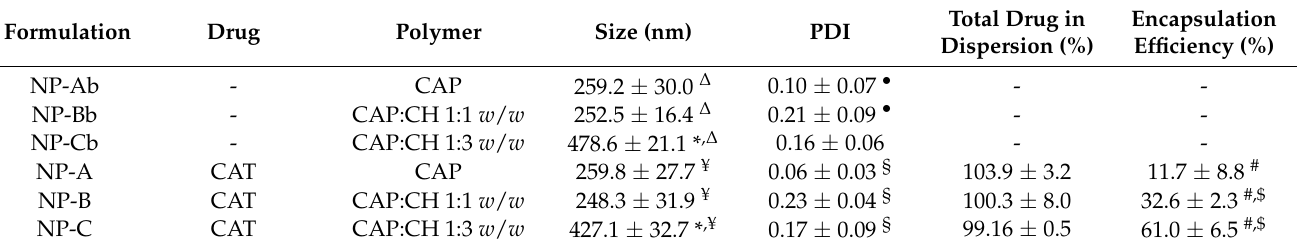
Table 1. Composition and physicochemical properties of the